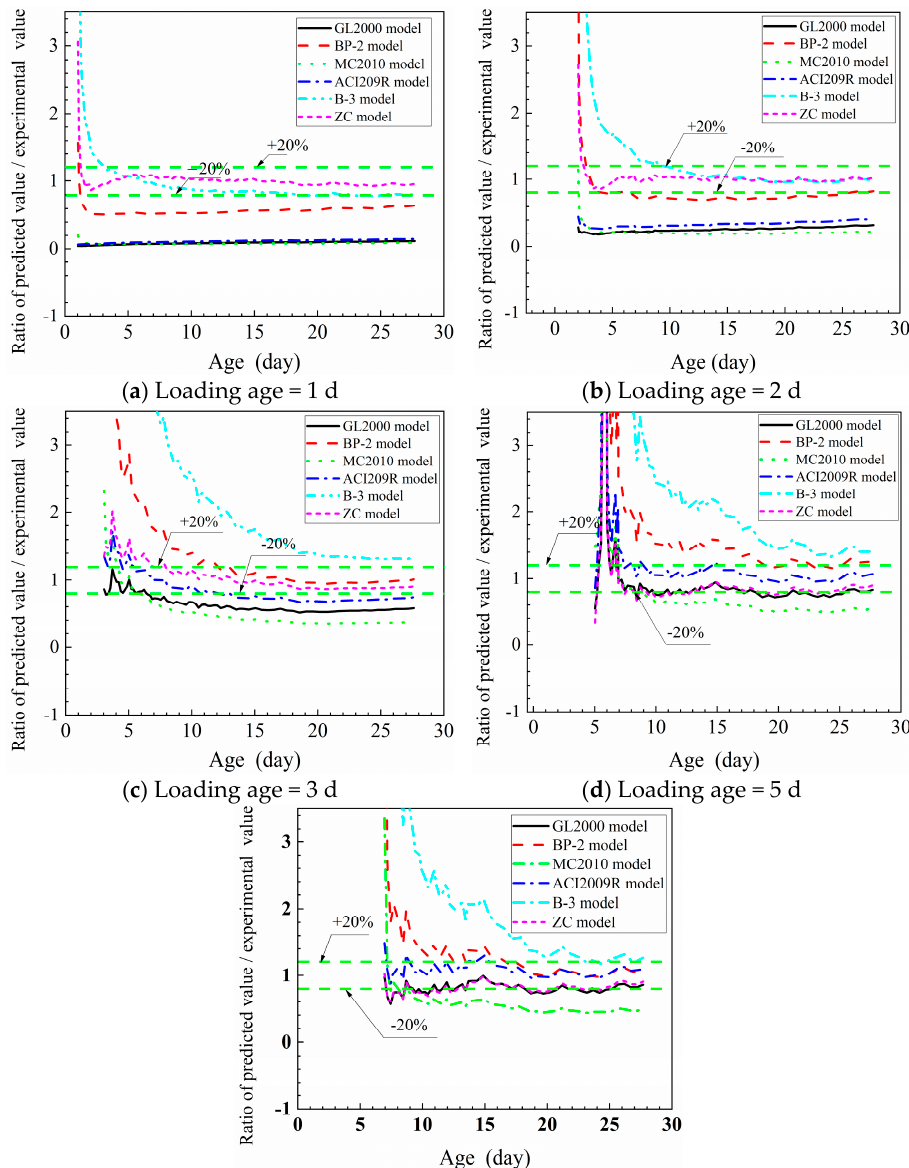
Figure 5. Precision analysis of prediction values of six models.